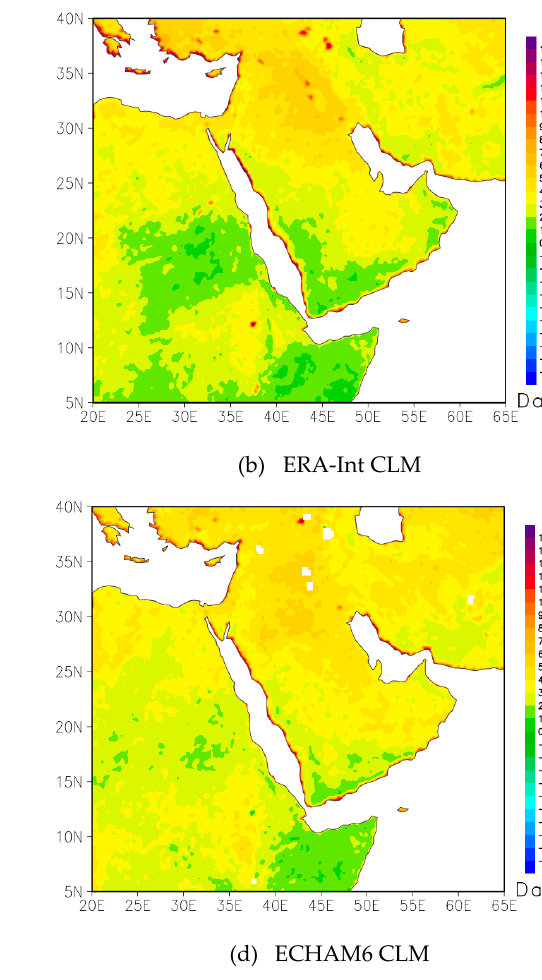
Figure 7. Spatial distribution of annual cold nights (TN10p) for ( a ) ERA–Int BATS, ( b ) ERA–Int CLM, ( c ) ECHAM6 BATS, ( d ) ECHAM6 CLM, ( e ) GFDL BATS, ( f ) GFDL CLM, ( g ) HadGEM BATS, and ( h )